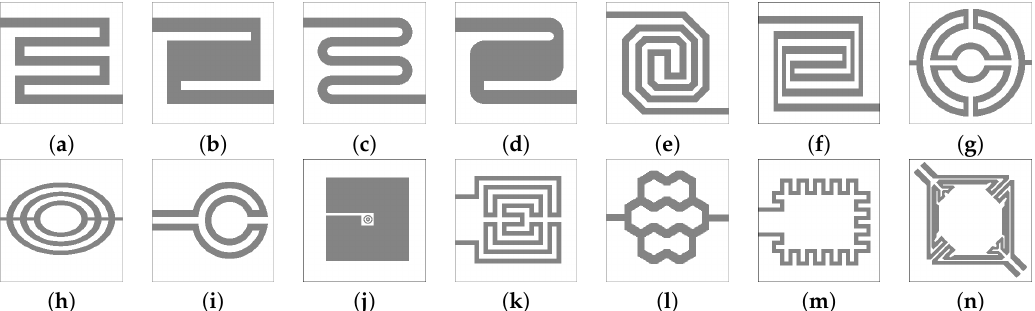
Figure 11. Microheater geometries characterized and modeled over the last decades. The shapes depicted are: ( a ) Meander, ( b ) S-meander, ( c ) Curved, ( d ) S-curved, ( e ) Double spiral, ( f ) Square double spiral, ( g ) Drive wheel, ( h ) Elliptical, ( i ) Circular, ( j ) Plane plate, ( k ) Fin shape, ( l ) Honeycomb, ( m ) Loop shape, ( n )